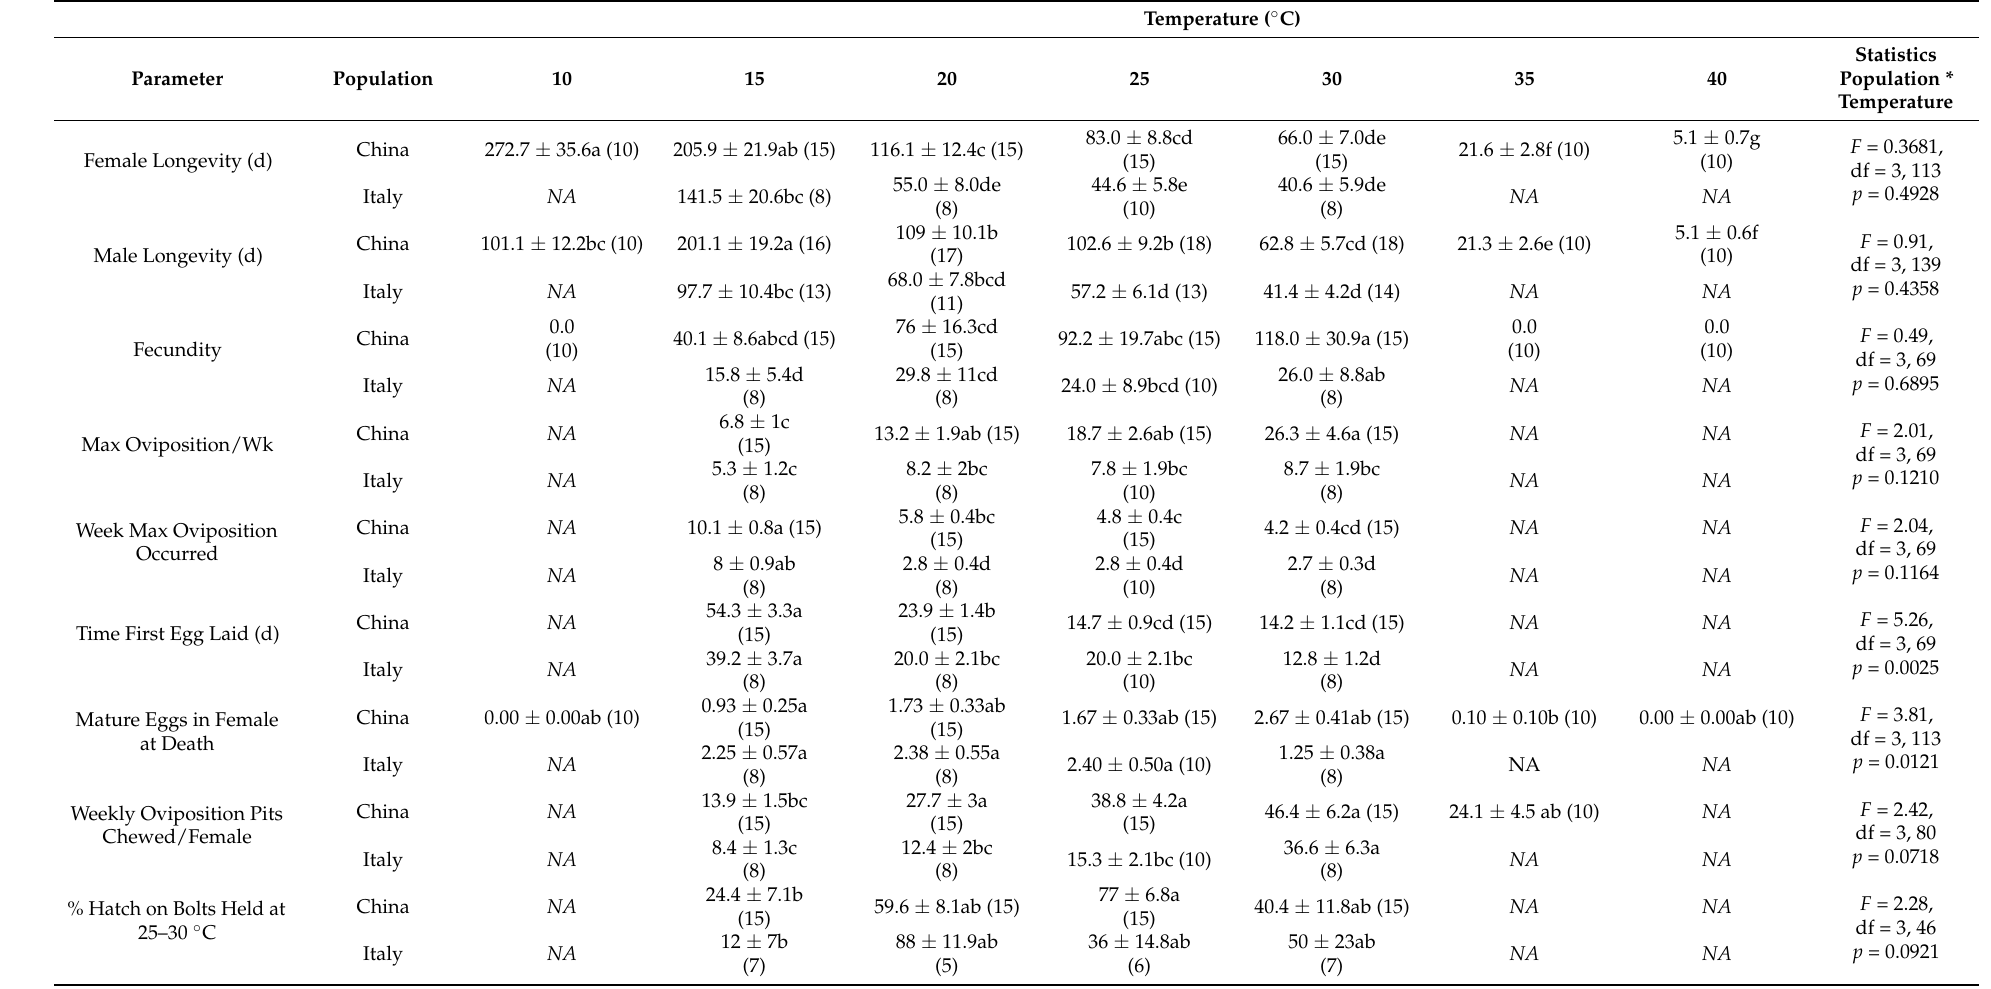
Table 1. Effects of temperature on Anoplophora chinensis adult survival and reproduction ((mean ± SE (n) or percentage (n)). Means were compared between each temperature and population combination for each